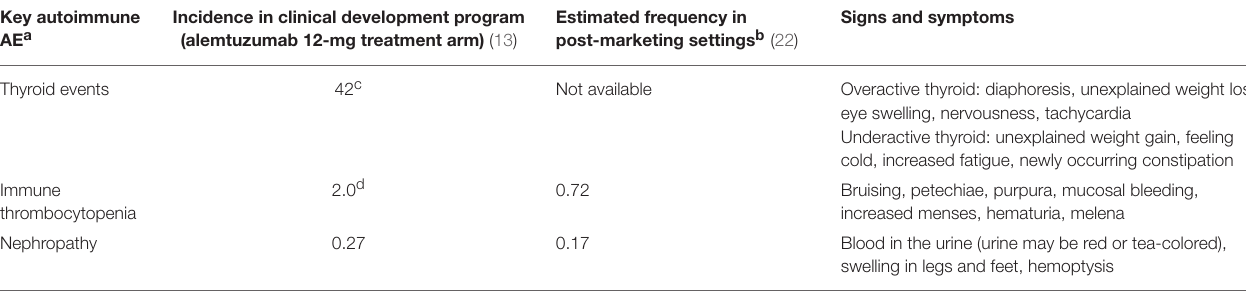
TABLE 1 | Clinical trial incidence, post-marketing frequency, and signs and symptoms of key autoimmune events after treatment with alemtuzumab. Key autoimmune AE